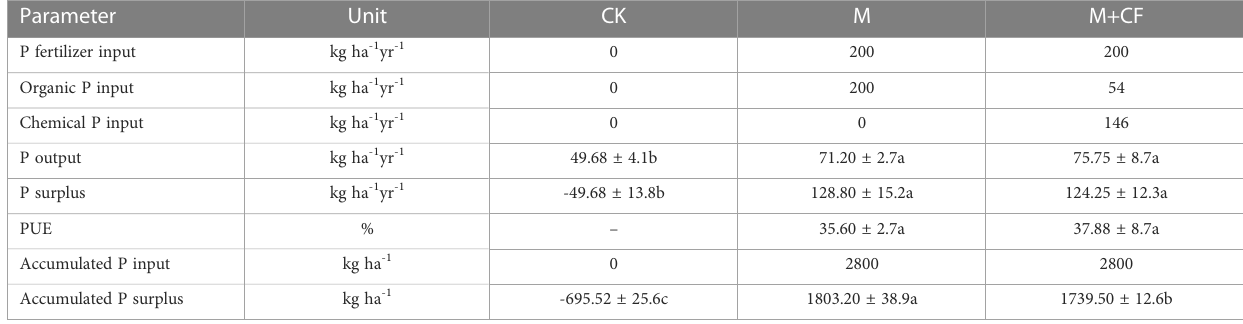
TABLE 2 Mean annual P fertilizer input (including organic P and chemical P input), P removal, and P surplus as affected by 14-year treatments that open- fi eld rotated vegetables had been in production.